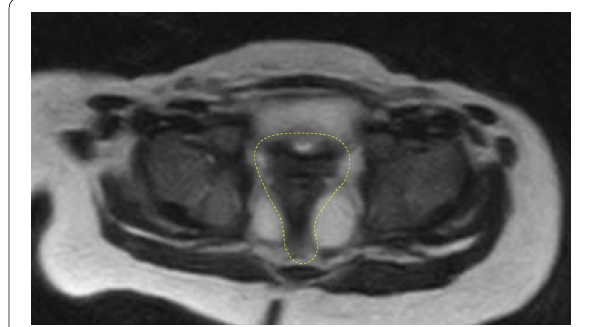
Fig. 2 Preoperative MRI scans. T2-weighted images (axial view). Muscle complex are outlined by dot line